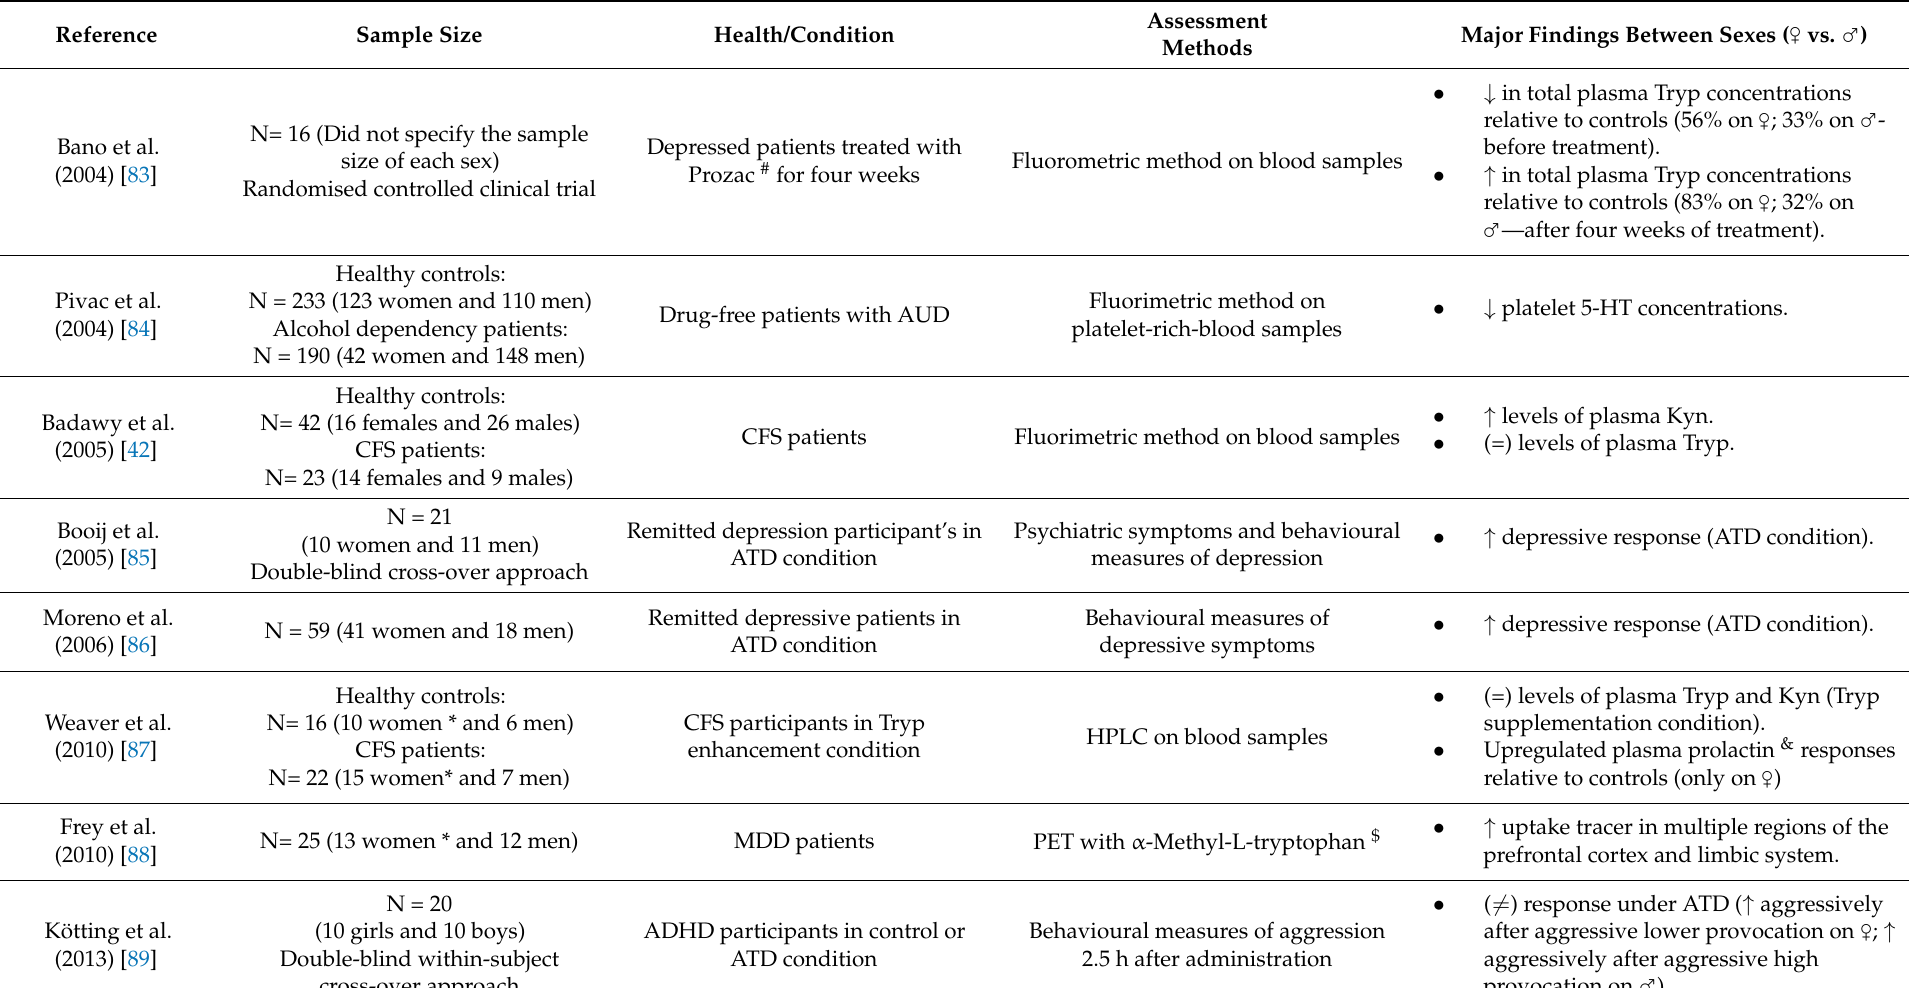
Table 4. Summary of clinical studies included in this